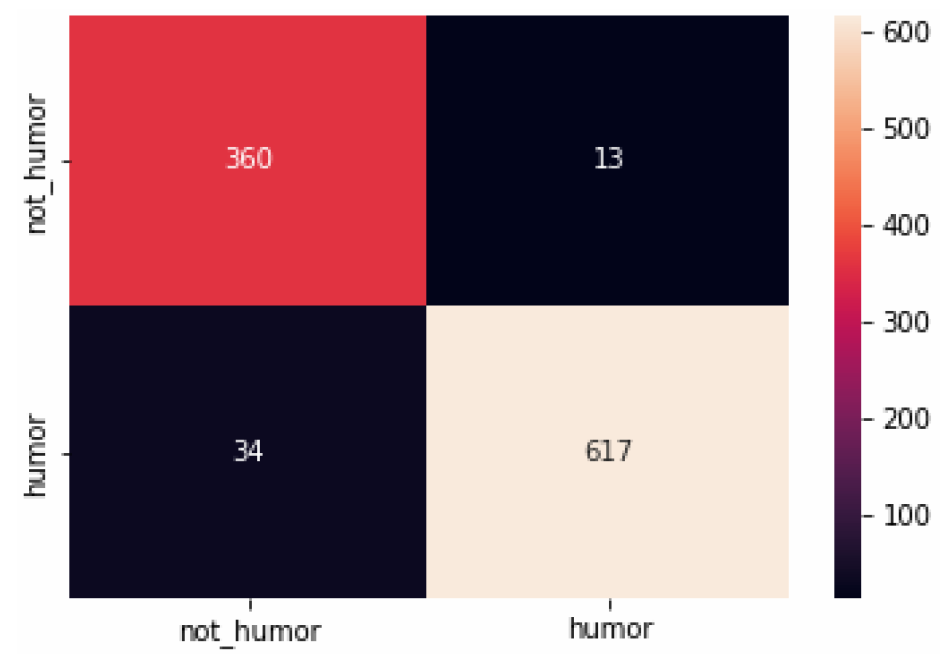
Figure 3. Confusion matrix of each model on model on SemEval-2021 Task 7